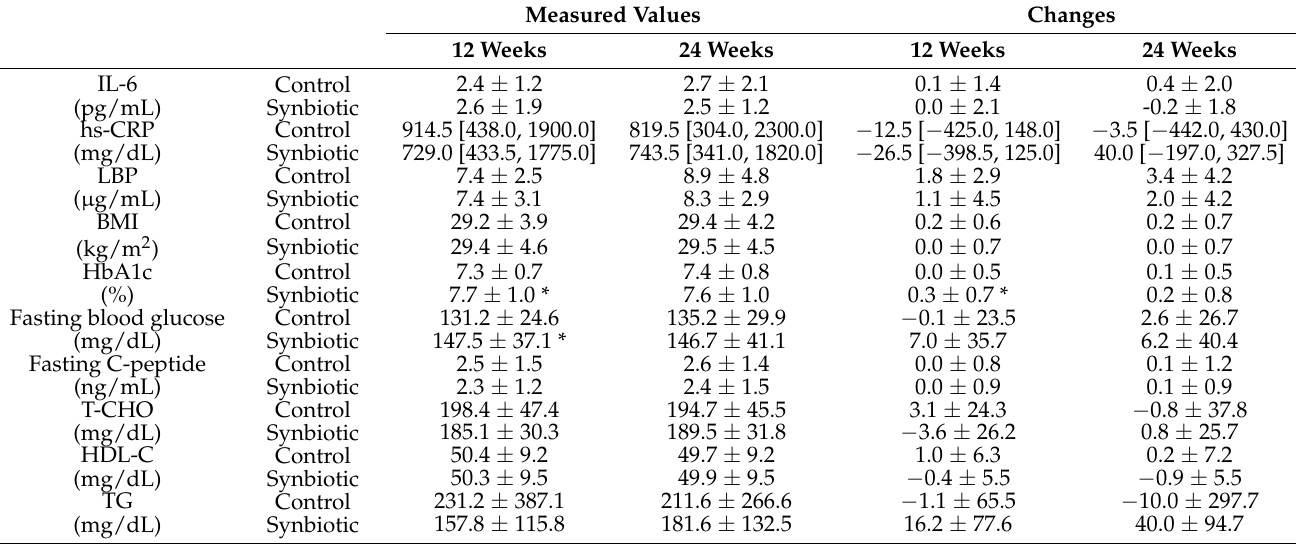
Table 2. Serial changes in clinical parameters in the control and synbiotic